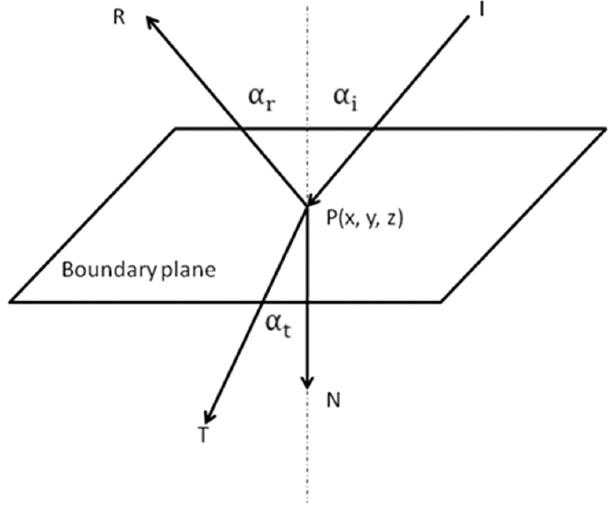
Fig. 1. The re°ection and refraction of